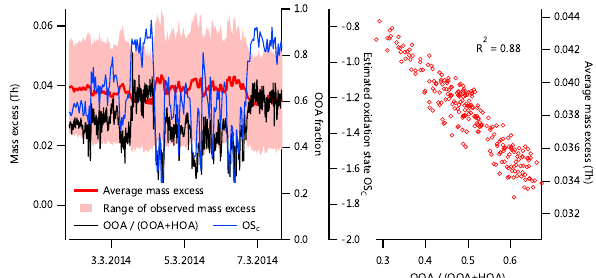
Figure 15. Time series (left) and regression (right) of the average mass excess and OOA fractions. Shown also the time series of the estimated carbon oxidation state from mass excess